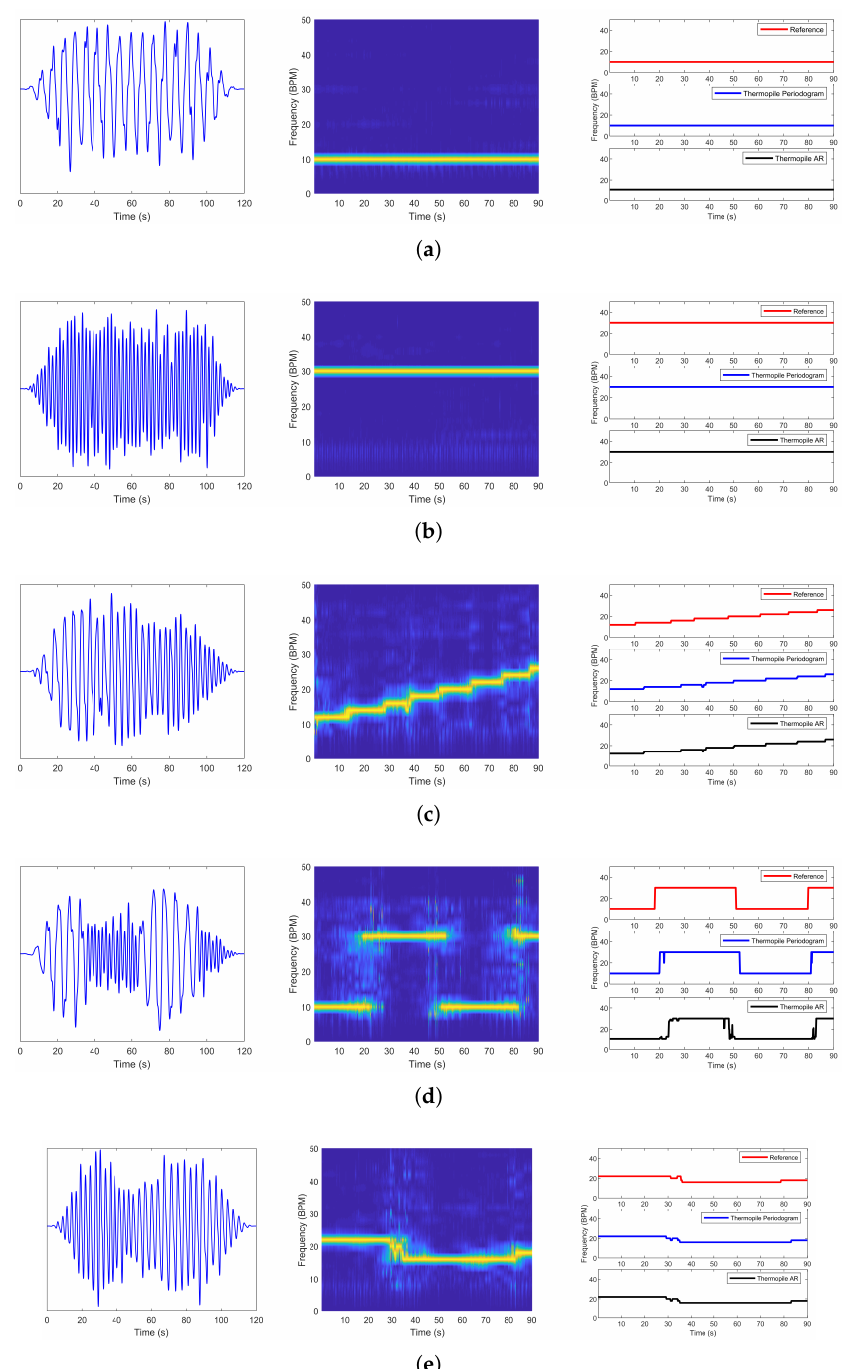
Figure 6. Results obtained for Dataset B with different patterns; on the left the time domain signal, in the middle the Fourier spectrum per each window, and on the right the RR extracted with both the periodogram and AR and the impedance pneumography one. ( a , b ) Collected during constant breathing pattern at 10 and 30 BPM, respectively; ( c ) chirp pattern; ( d ) pattern with two sudden changes; ( e ) spontaneous breathing. The time axis in the FFT and in the extracted RR figures ends at 90 s even though the original signal has a duration of 120 s. This is due to the sliding window approach using a window size of 30